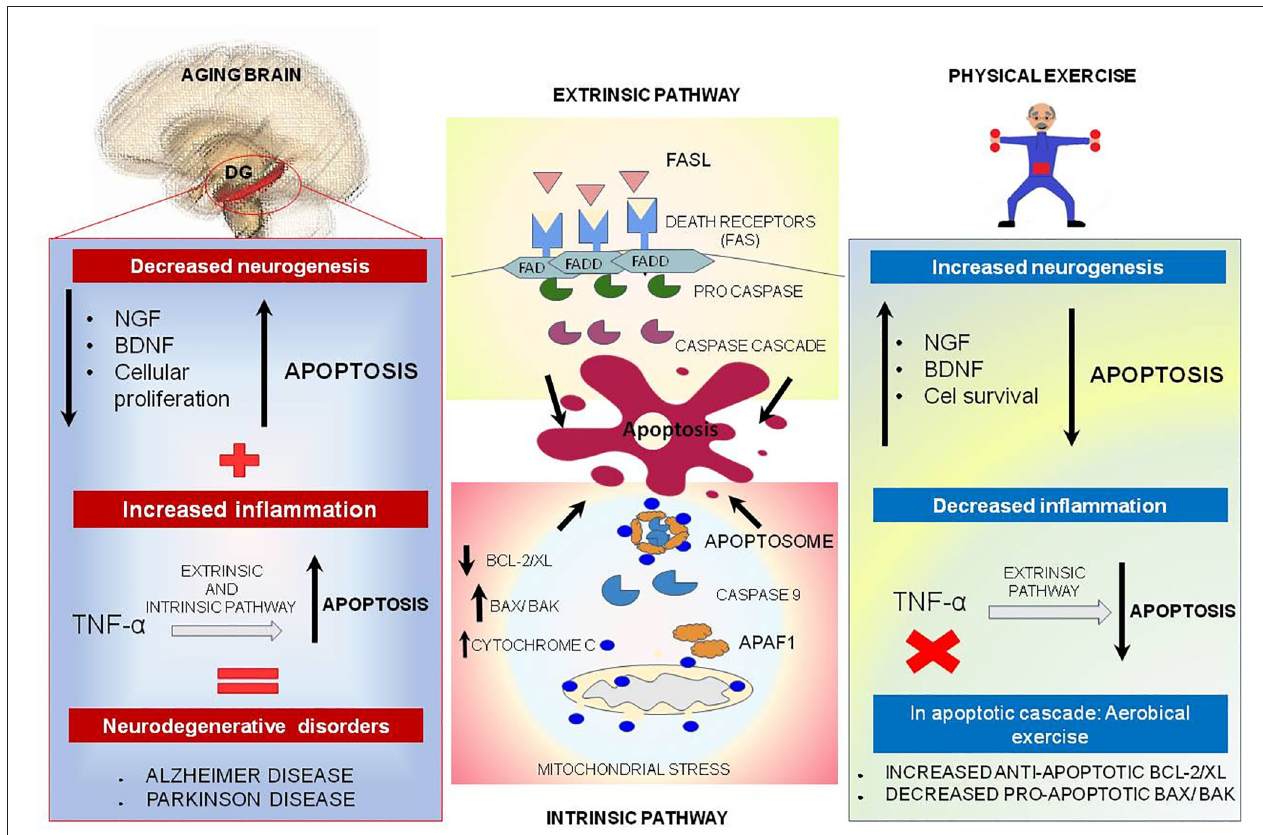
FIGURE 4 | Physical exercise actions against aging brain and the apoptotic process. In the central boxes: Apoptosis can be divided into extrinsic and intrinsic signaling pathways. The extrinsic pathway illustrated in the upper central box is induced by death receptors such as FASL, and their ligands, FAS. On the other hand, the intrinsic pathway illustrated in the central inferior box is induced by signs that cause changes in the mitochondrial membrane, called mitochondrial outer membrane permeabilization (MOMP). This process generates macropores on the mitochondrial surface and a release of Cytochrome C, which once released by mitochondria binds to and induces APAF-1 and pro-caspase 9, forming the Apoptosome complex, which activates caspase 9 causing cell death. This pathway is mediated by anti-apoptotic proteins such as BCL-2 and BCL-XL, and pro-apoptotic proteins such as BAX and BAK. In the left box, brain aging is illustrated, and a decrease of neurotrophic factors such as nerve growth factor (NGF) is observed, and brain-derived neurotrophic factor (BDNF), especially in dentate gyrus located on hippocampus, may be related to decreased cell proliferation and increased apoptosis. In addition, TNF-alpha, a pro-inflammatory cytokine, can increase the apoptosis process by intrinsic and extrinsic pathways and lead to the emergence of neurodegenerative diseases. Physical exercise effects, illustrated in the right box, act in reverse, increasing the amount of NGF and BDNF, increasing cell survival and culminating in decreased apoptosis. In addition, physical exercise inhibits the production of pro-inflammatory cytokine TNF-alpha which, in low quantities, decreases the extrinsic apoptosis